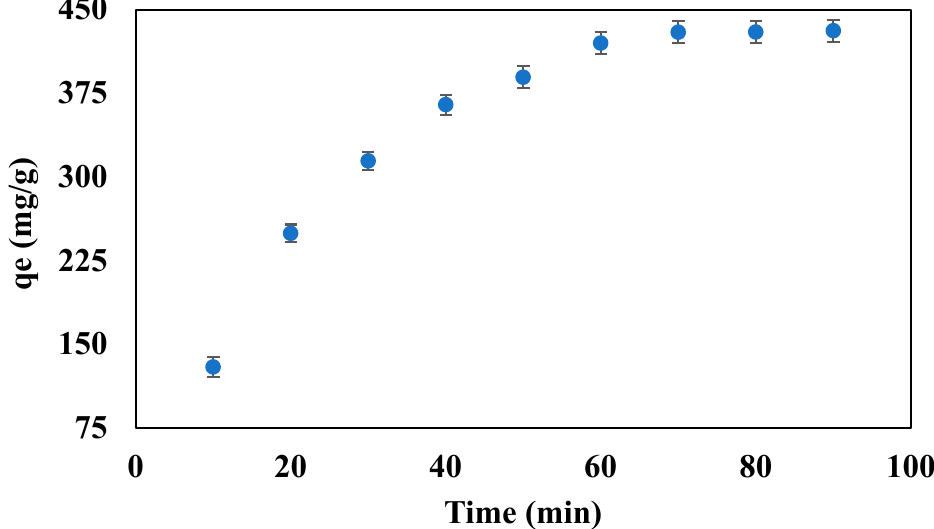
Figure 6. Effect of the contact time on the adsorption capacity of the beads at 600 ppm initial oil concentration, pH 10, and 10 mg beads dosage.